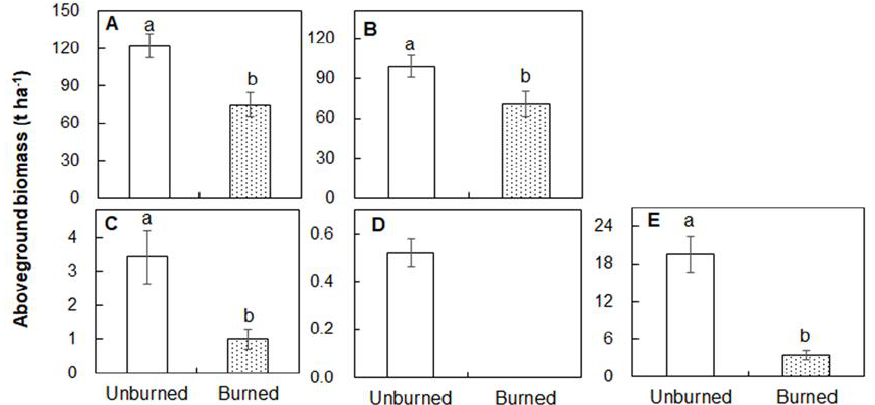
Figure 3. Differences in total aboveground biomass ( A , total; B , tree layer; C , shrub layer; D , herbaceous layer; E , litter) between the unburned and burned plots. Different letters indicate significant differences between treatments at p < 0.05. Values are presented as the means ± standard error.